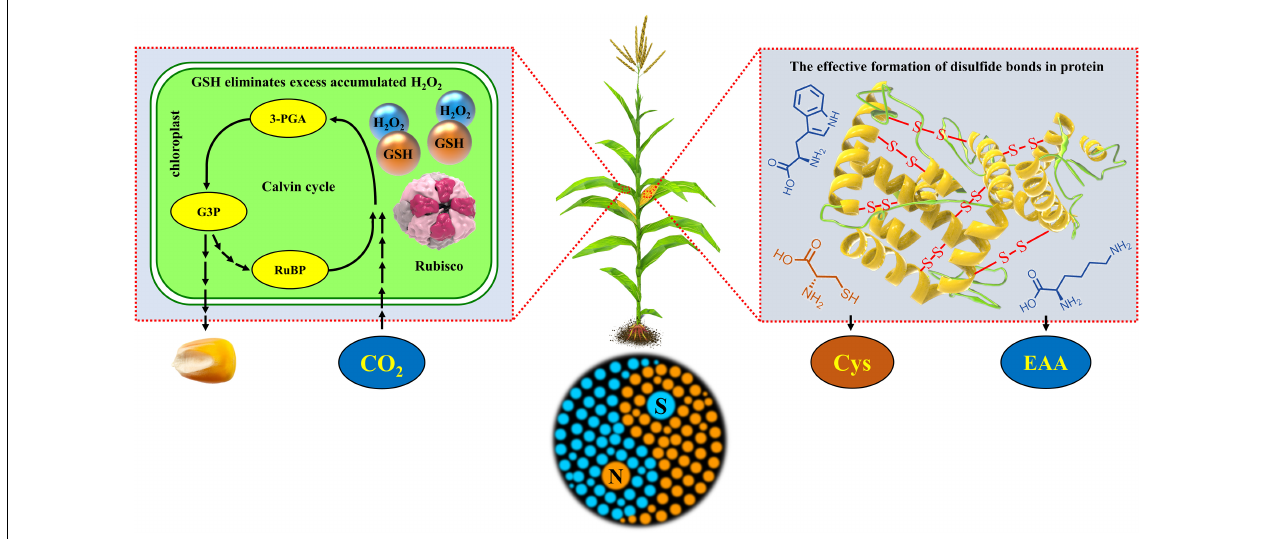
FIGURE 11 | Schematic diagram of the synergistic mechanism of N and S synergistically improving maize yield, grain protein concentration, and quality. The box on the left represents the physiological response during the Calvin cycle in the chloroplast of maize leaves, and the box on the right represents the synthesis and accumulation of protein in maize grains. RuBP, ribulose-1,5-bisphosphate; 3-PGA, 3-phosphoglycerate acid; G3P, glyceraldehyde-3-phosphate; Rubisco, ribulose-1,5-bisphosphate carboxylase/oxygenase; GSH, glutathione; H 2 O 2 , hydrogen peroxide; Cys, cysteine; EAA, essential amino acids (methionine, lysine, tryptophan, etc.); -S- S-, disulfide bonds in